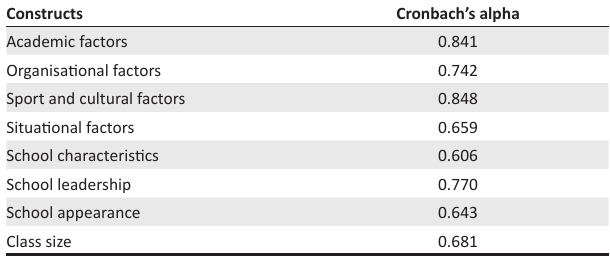
TABLE 3: Demographic profile of